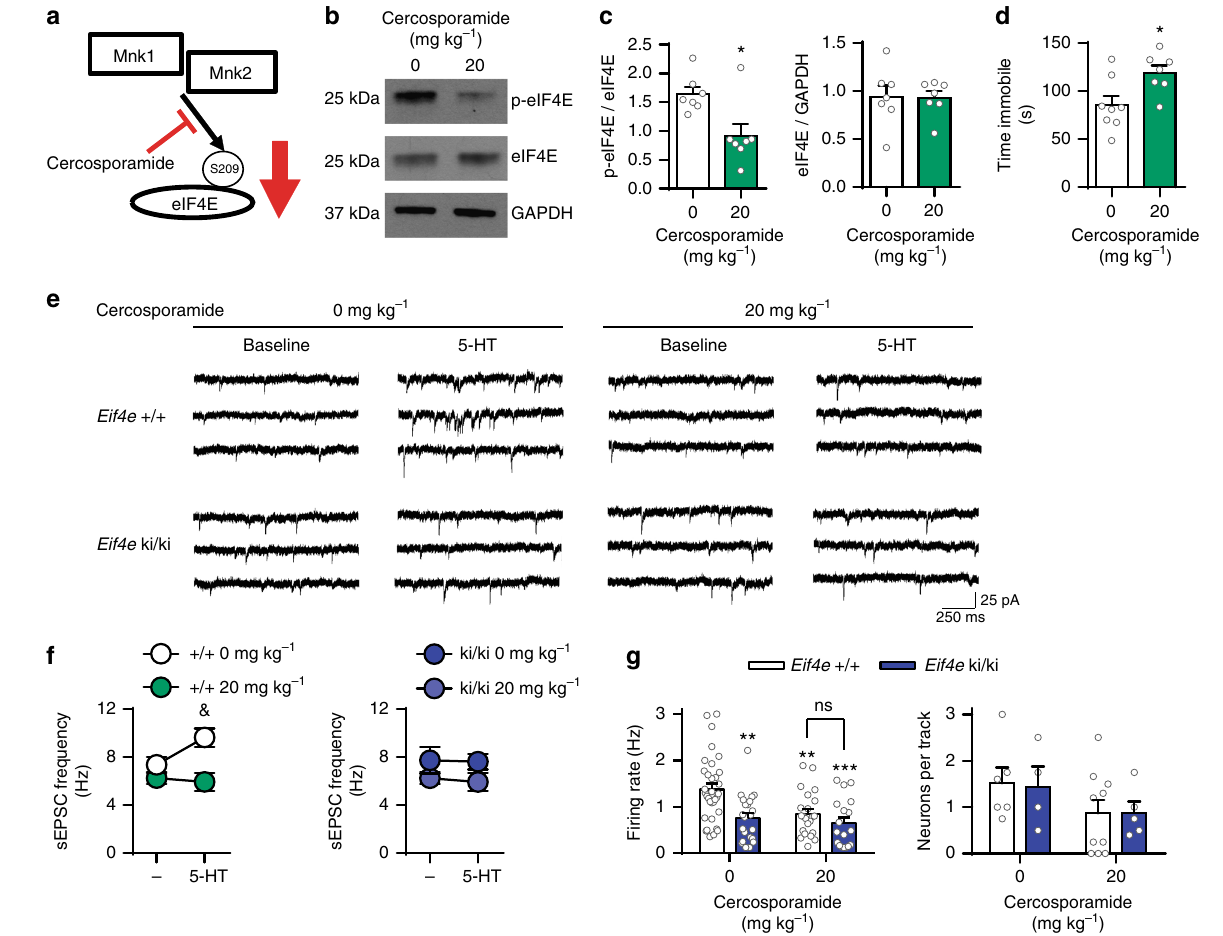
Fig. 4 Pharmacological inhibition of MNK1/2 induces despair-like behavior and 5-HT synaptic impairments. a Cercosporamide, an MNK1 and MNK2 inhibitor, was administered for 5 consecutive days to wild-type mice (IP, 20 mg kg − 1 ). b Representative western blot images for phosphorylated eIF4E (p- eIF4E), total eIF4E and GAPDH in the cortex-hippocampus of mice treated with vehicle or cercosporamide. c Average levels of p-eIF4E in vehicle and cercosporamide-treated wild-type mice (vehicle (0 mg kg − 1 ), n = 7; cercosporamide, n = 7). d Cercosporamide administration induced increased immobility in the Forced Swim Test (FST) in wild-type mice (vehicle (0 mg kg − 1 ), n = 8; cercosporamide, n = 7). e Representative sEPSC traces from recordings in layer V mPFC from wild-type or Eif4e ki/ki mice treated with vehicle or cercosporamide. f Layer V mPFC sEPSC frequency of wild-type (left panel, vehicle n = 5 neurons from three mice, cercosporamide n = 6 neurons from two mice) or Eif4e ki/ki mice (right panel, vehicle n = 5 neurons from 2 mice, cercosporamide n = 7 neurons from 3 mice) treated with vehicle or cercosporamide. g Firing rate of 5-HT DR neurons in wild-type and Eif4e ki/ki mice treated with vehicle or cercosporamide ( Eif4e + / + : Vehicle 33 neurons from 6 mice, cercosporamide 22 neurons from 10 mice; Eif4e ki/ki: vehicle 22 neurons from 4 mice, cercosporamide 18 neurons from 4 mice). * p < 0.05, ** p < 0.01, ***p < 0.001 vs vehicle-treated wild-type mice; & p < 0.05 vs. saline- treated Eif4e + / + (see Supplementary Table 2 for detailed results of statistical HT post-synaptic excitation in the mPFC, in a manner similar to depression-inducing chronic stress 31,39 .